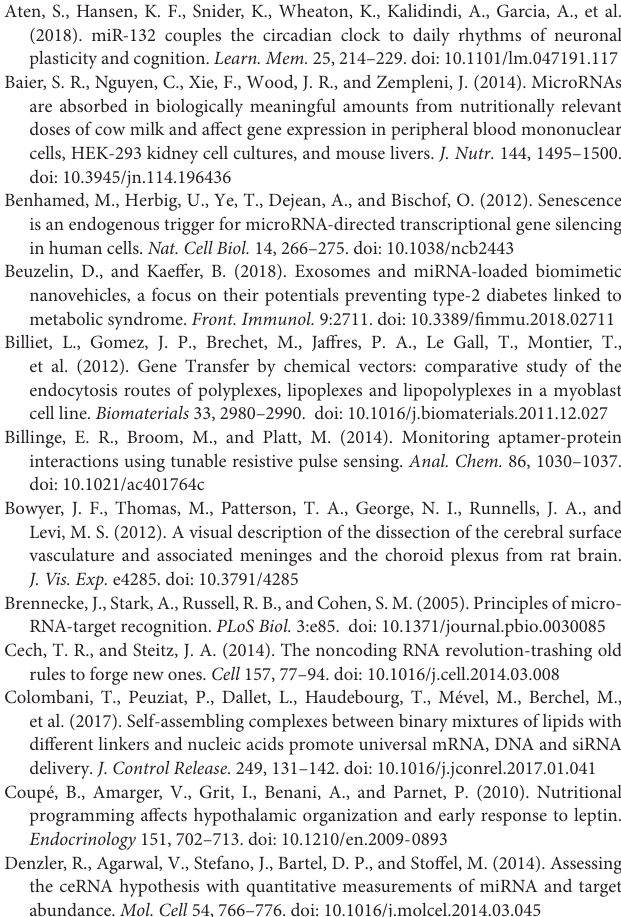
TABLE S1 | Raw data corresponding to the tracking of miR-320-3p in rat pup organs after loading at light on (ZT-8H) or off (ZT-20H). The file contains q-PCR data in Cq of miR-320-3p detection in stomach or liver of the experimental groups. TABLE S2 | Raw data corresponding to the evaluation of c-myc, circadian clock transcripts and stat-1, in stomach and liver, following miR-320-3p or antagomiR